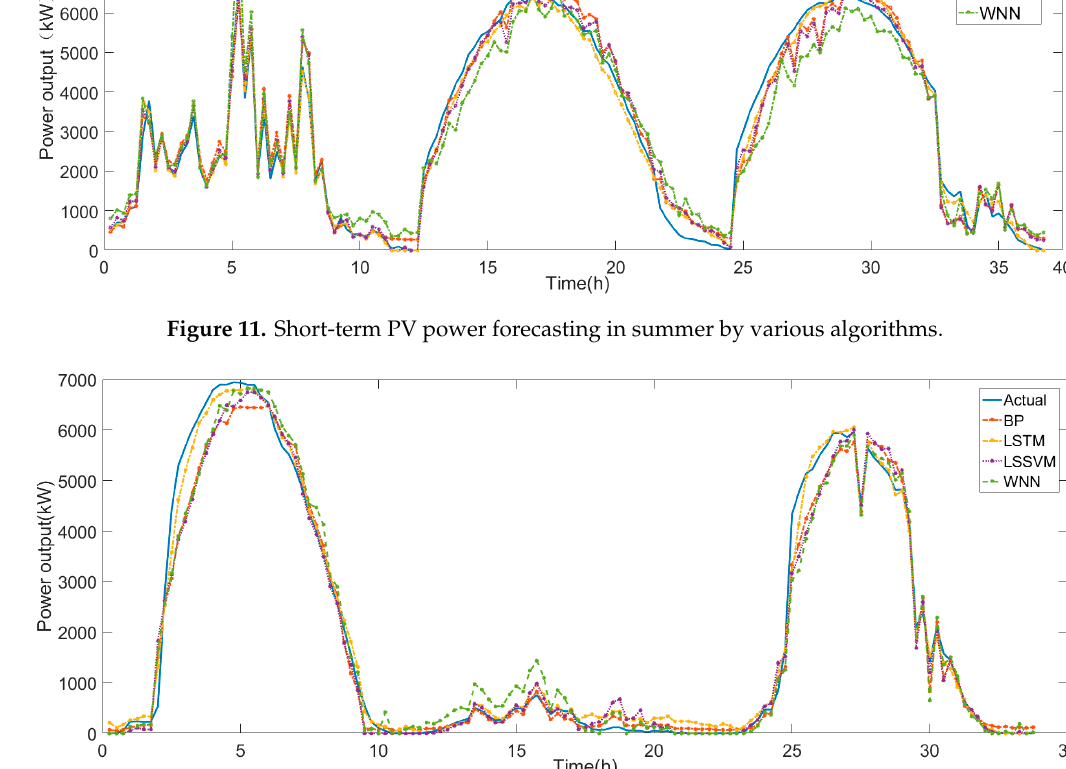
Figure 12. Short-term PV power forecasting in autumn by various algorithms.